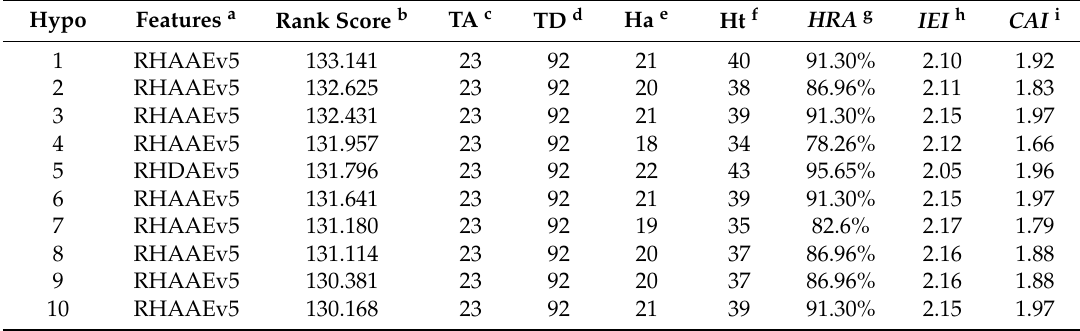
The validation results of the HipHop pharmacophore models for CDK2 ATP-competitive